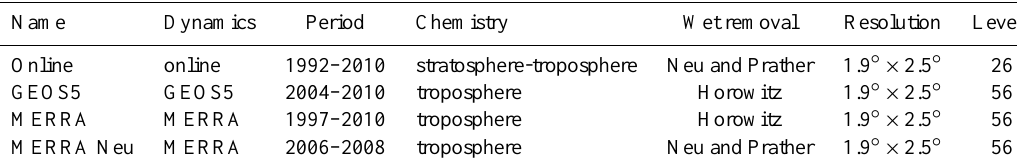
Fig. 4b. Annual (2006–2008) distribution of temperature at 700hPa (top, K) and total precipitation (bottom, mmday − 1 ) in GEOS5, MERRA and the online configurations (shown as absolute difference with respect to GEOS5, note different color scale). Table 6. Summary of simulations. All versions extend to ≈